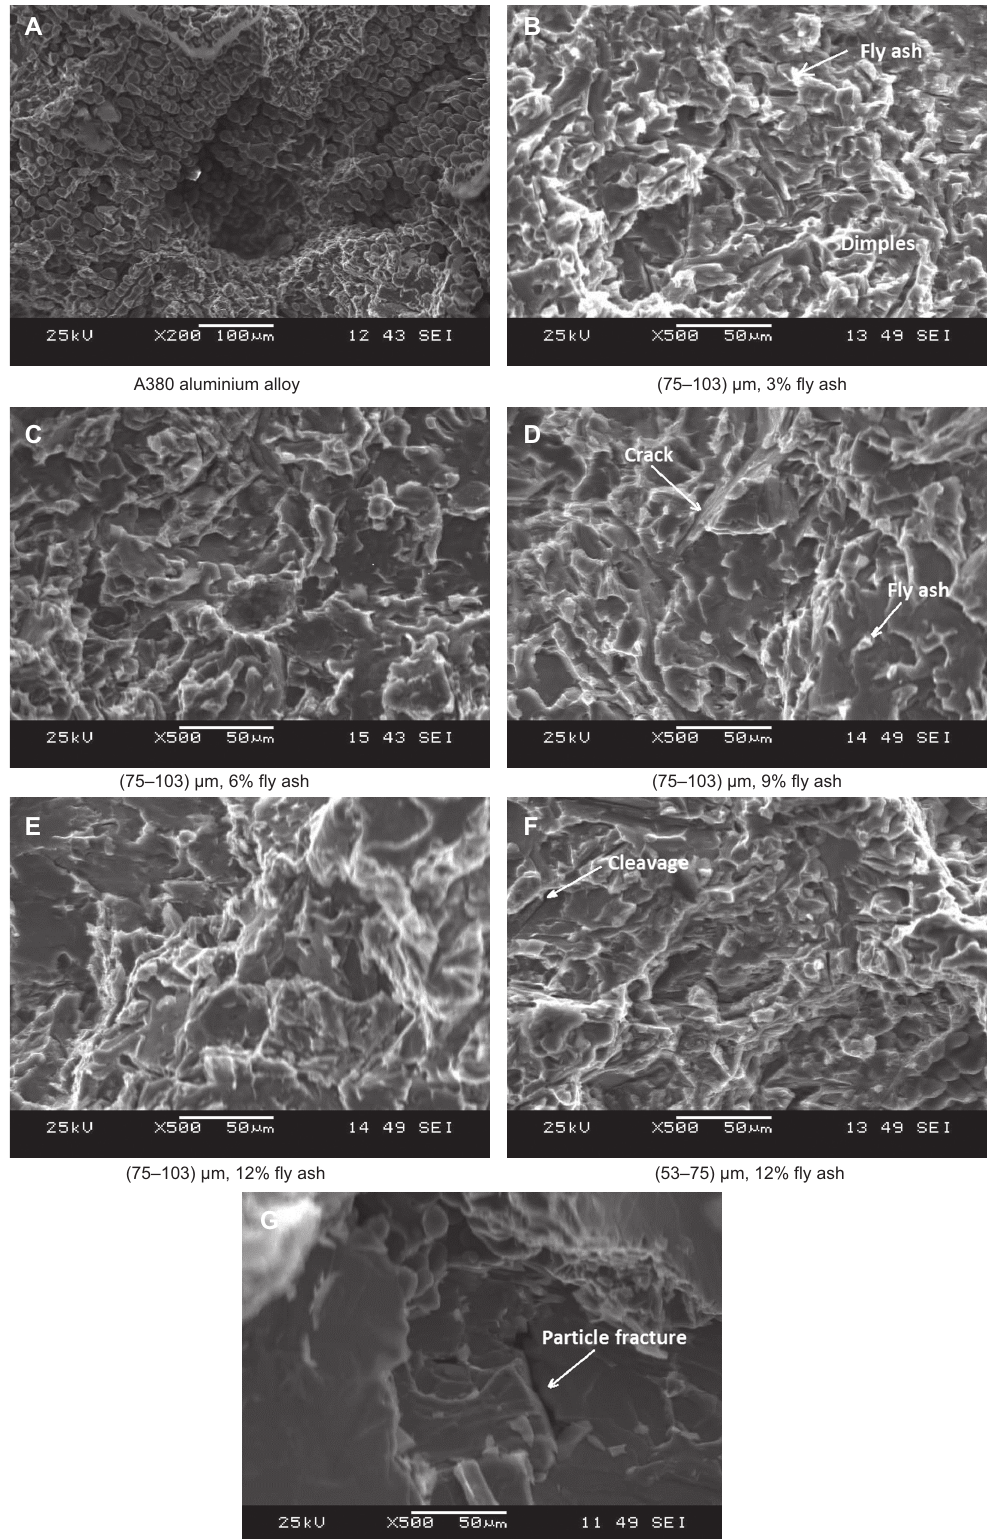
Figure 8 Fracture surfaces of the impact test